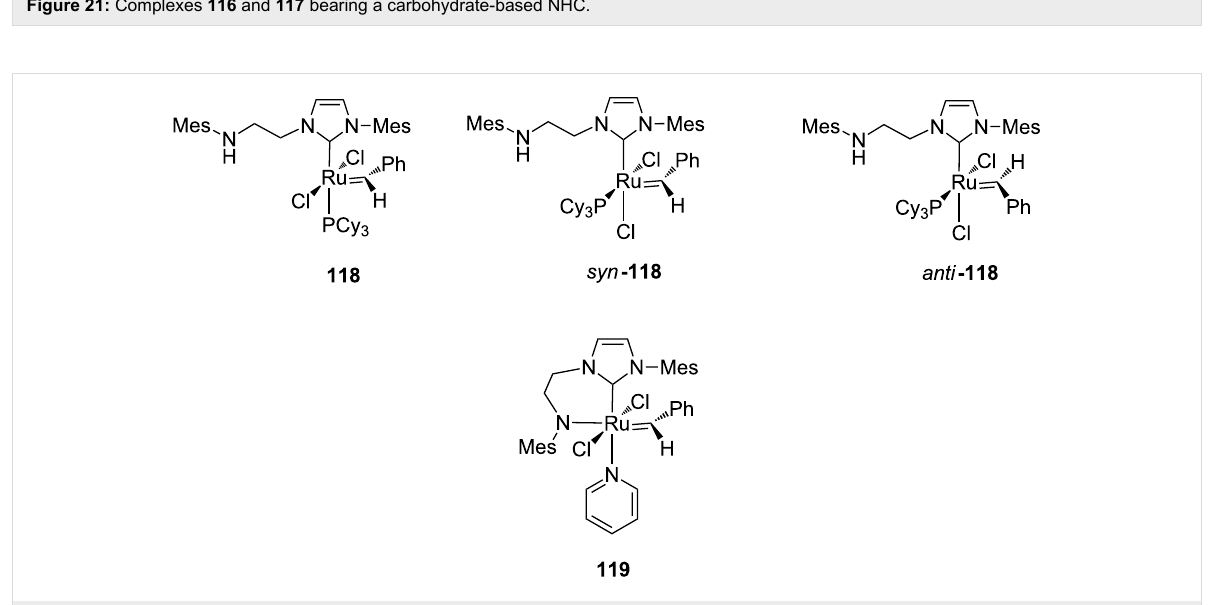
Figure 21: Complexes 116 and 117 bearing a carbohydrate-based NHC.